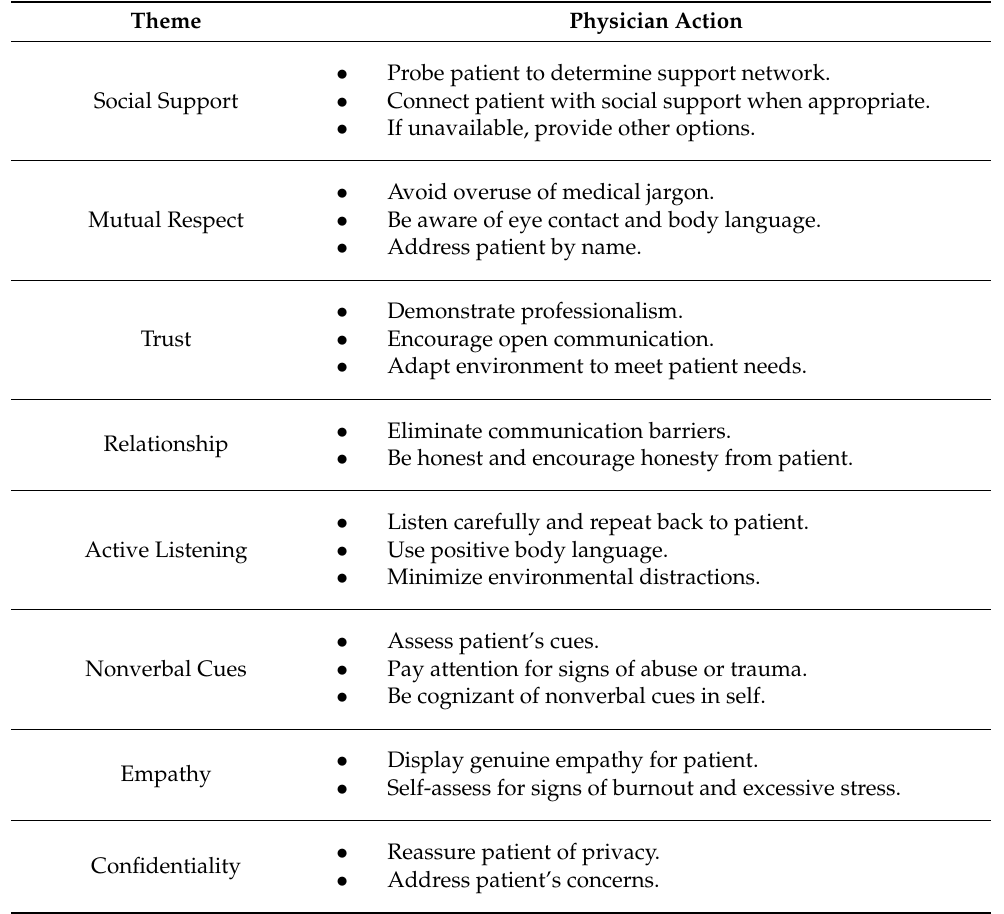
Table 1. Eight themes found in effective medical